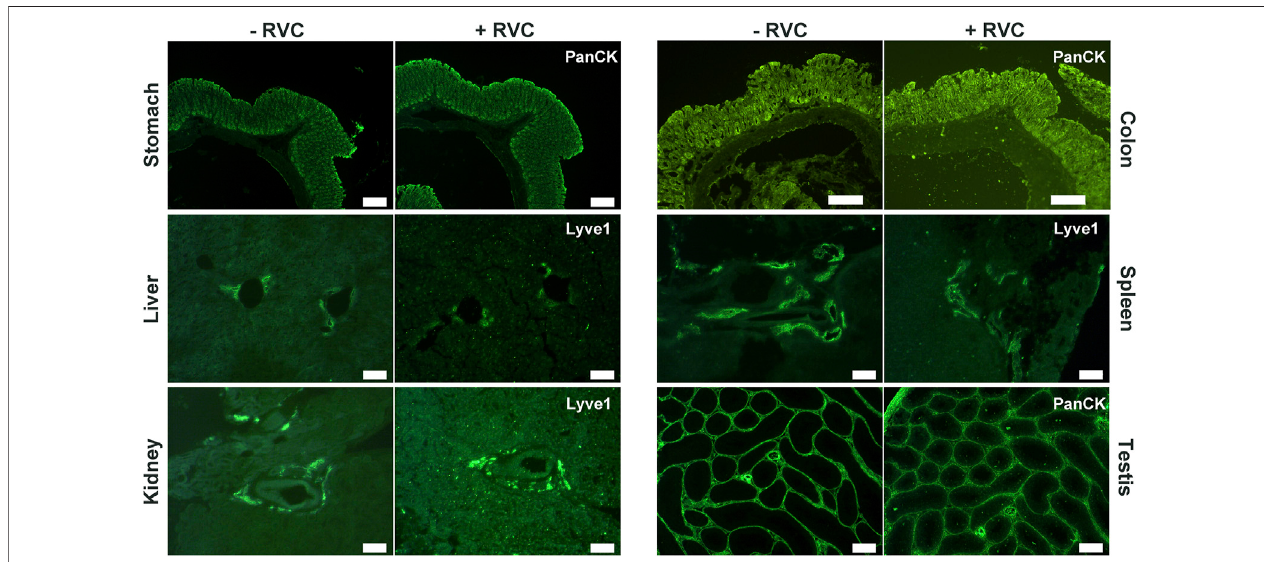
FIGURE 4 | High quality IF images obtained from various snap-frozen tissue sections with standard immunolabelling procedures in the presence of 10 mM RVC. The presence of RVC in the incubation solution apparently has no adverse effect on antibody-antigen interactions. Here, anti-Lyve1 labels lymphatic vessels and anti-PanCK labels epithelial cells. Scale bar: 200 μ m (stomach, colon, testis), 100 μ m (liver, kidney, spleen).